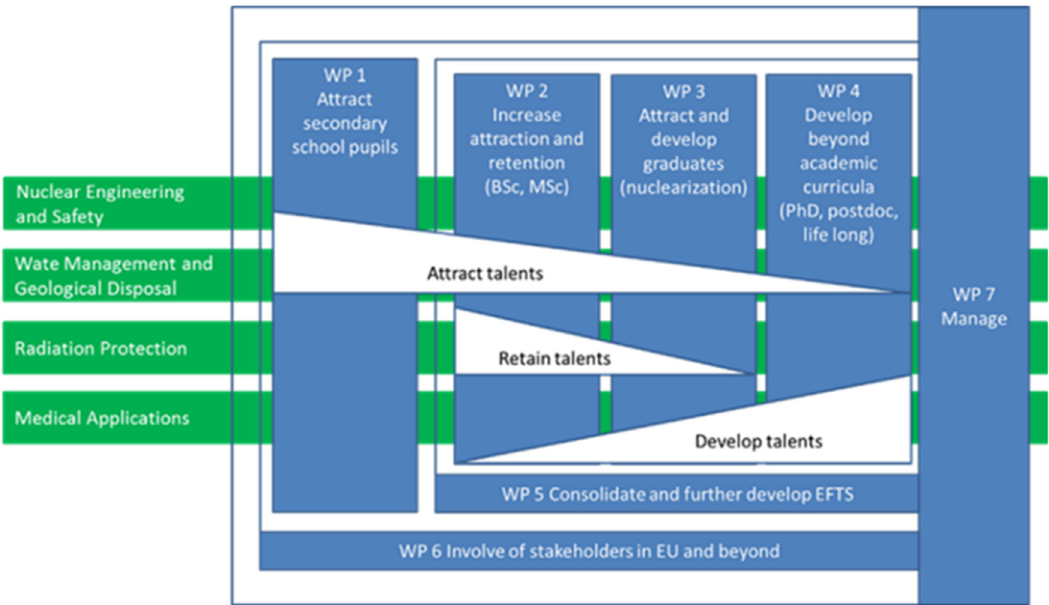
Fig. 10. Functional sketch of the ENEN+